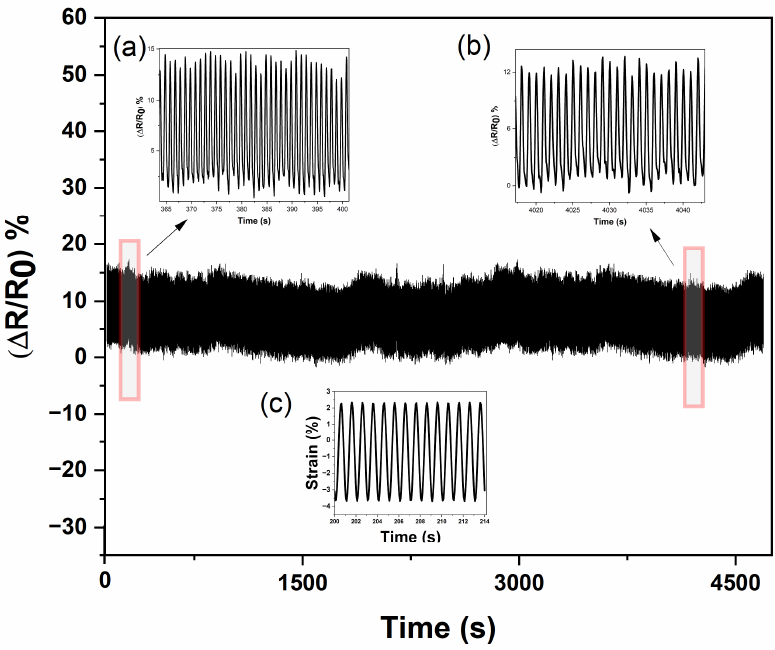
Figure 7. Durability and endurance test of the SEBS/CB 15% sensor. Insets ( a , b ) are the enlarged cyclic loading–unloading response, and ( c ) is the mechanical stimuli with respect to the electrome- chanical response.